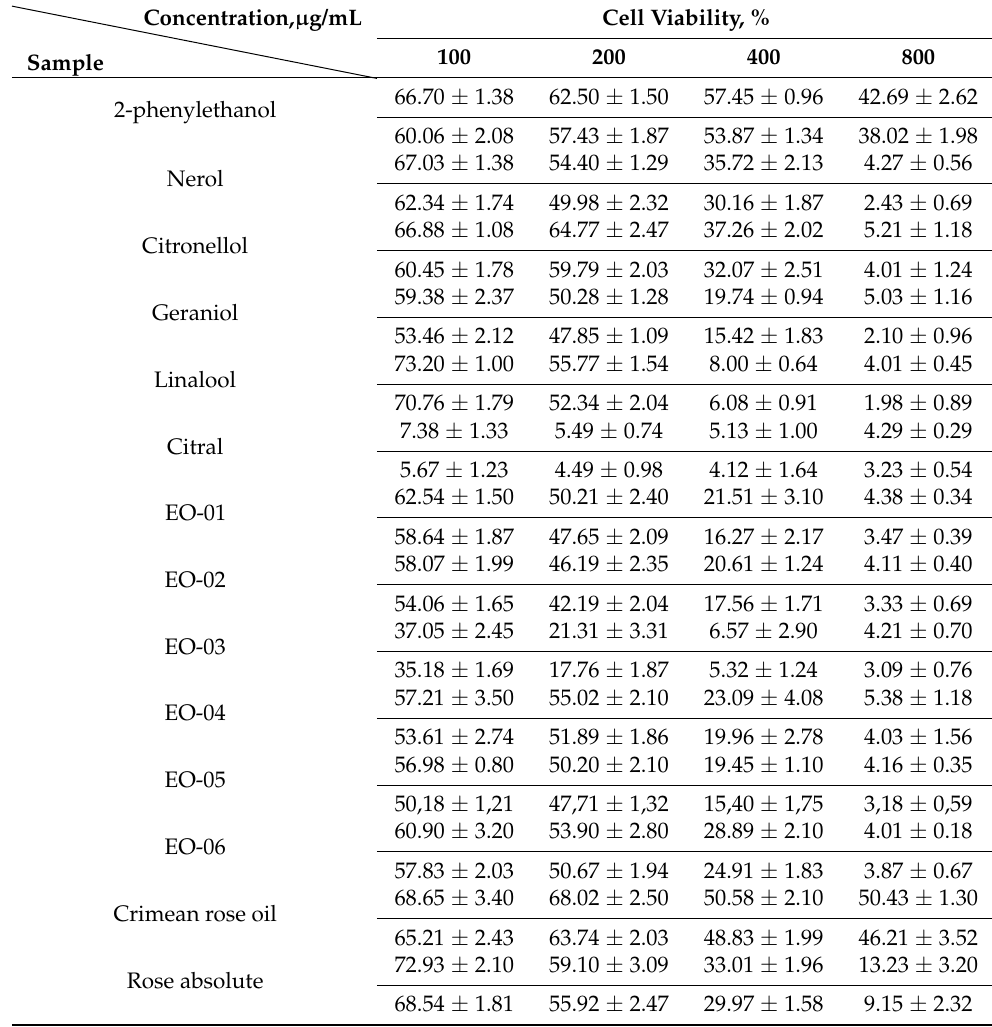
Table 2. Viability of cells treated with Eremothecium and rose oils and their components. MTT assay